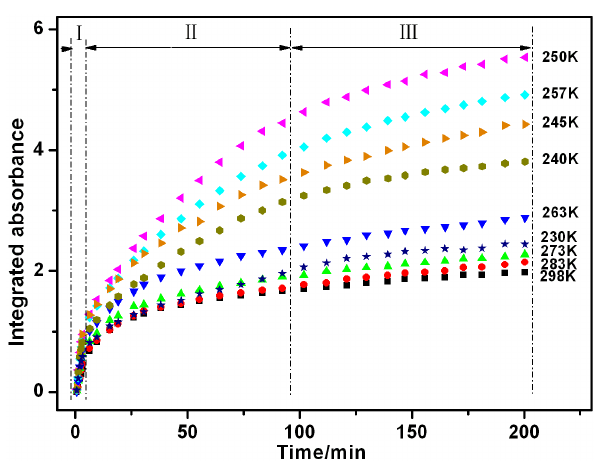
Fig. 3. The integrated absorbance of 1012–1240cm − 1 for sulfate for a series temperatures as a function of reaction time. I, II, and III stand for the initial region, the transition region, and the saturation region,